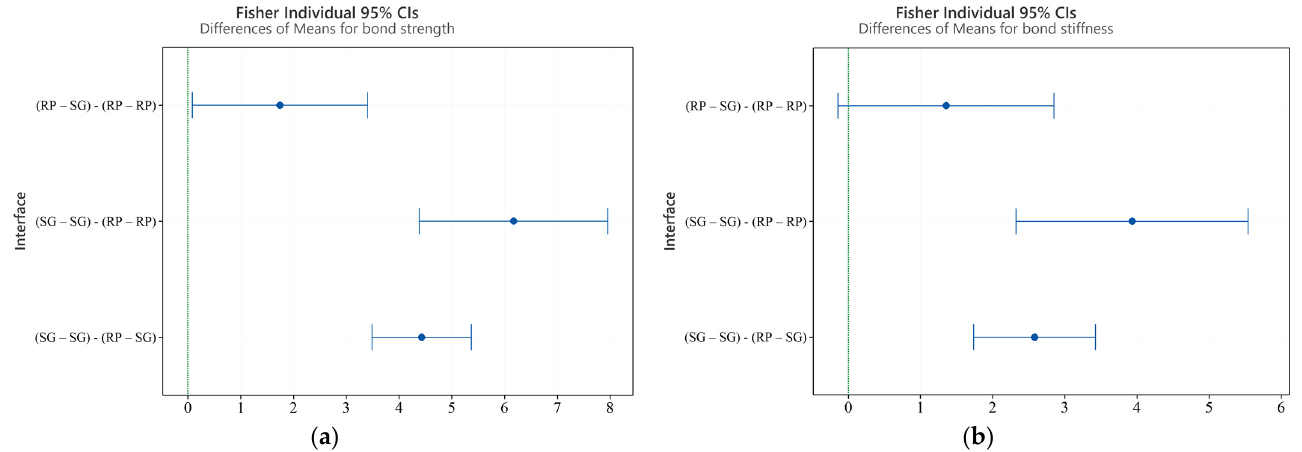
Figure 8. Pairwise comparison between species combinations for bond properties. ( a ) Post hoc analysis for t -test (bond strength) ( b ) Post hoc analysis for t -test (bond sti ff ness).